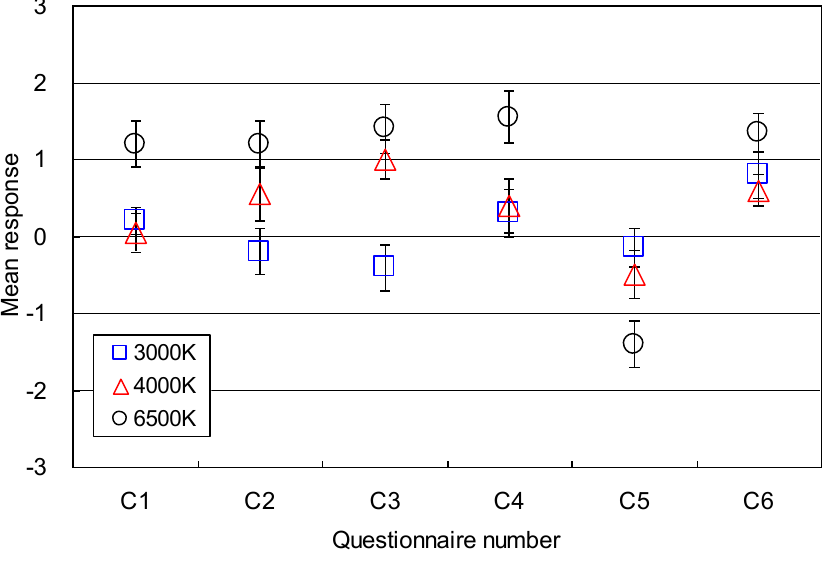
Figure 15. Visual comfort and annoyance (750 lx, Paper